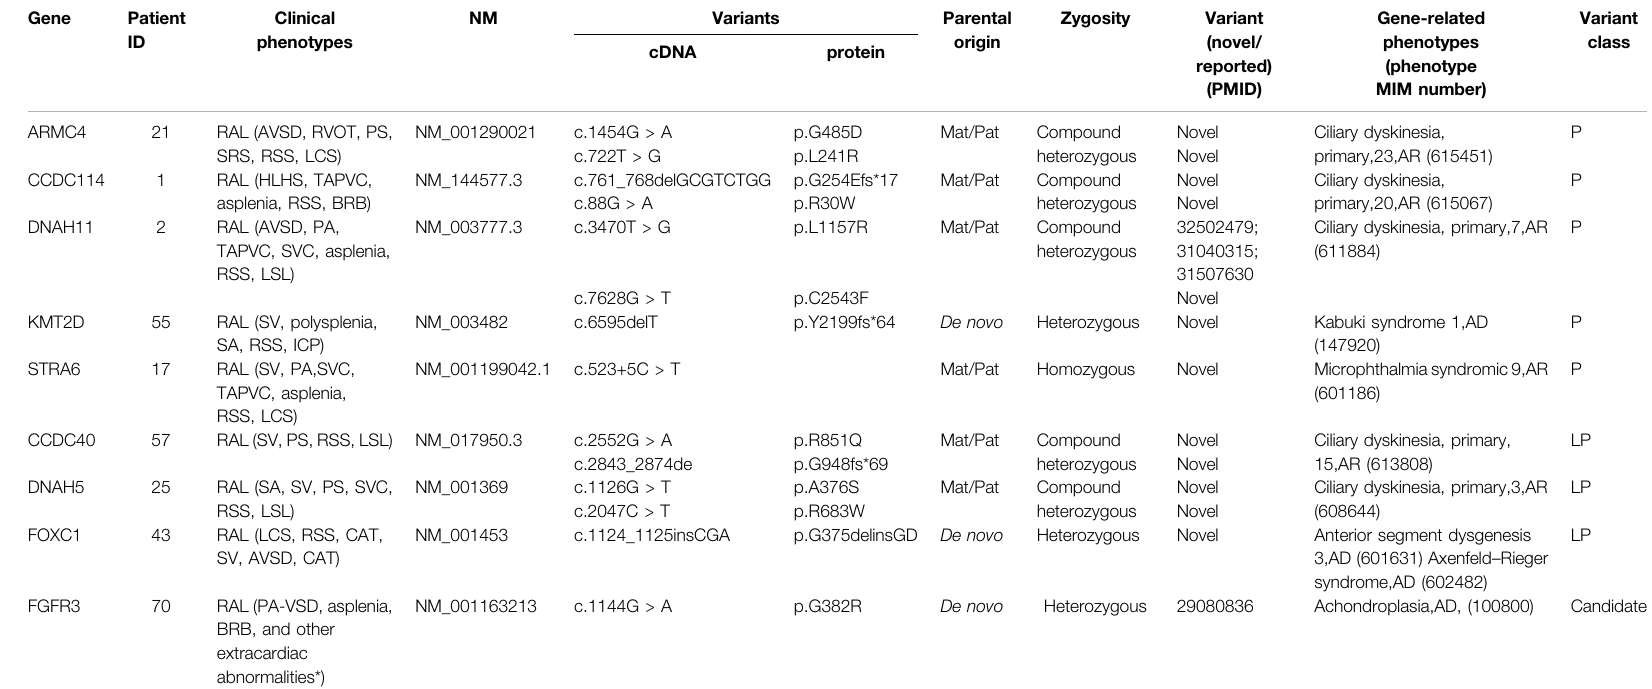
TABLE 3 | Genotype – phenotype information of patients diagnosed with pathogenic variants, likely pathogenic variants, or variants of uncertain signi fi